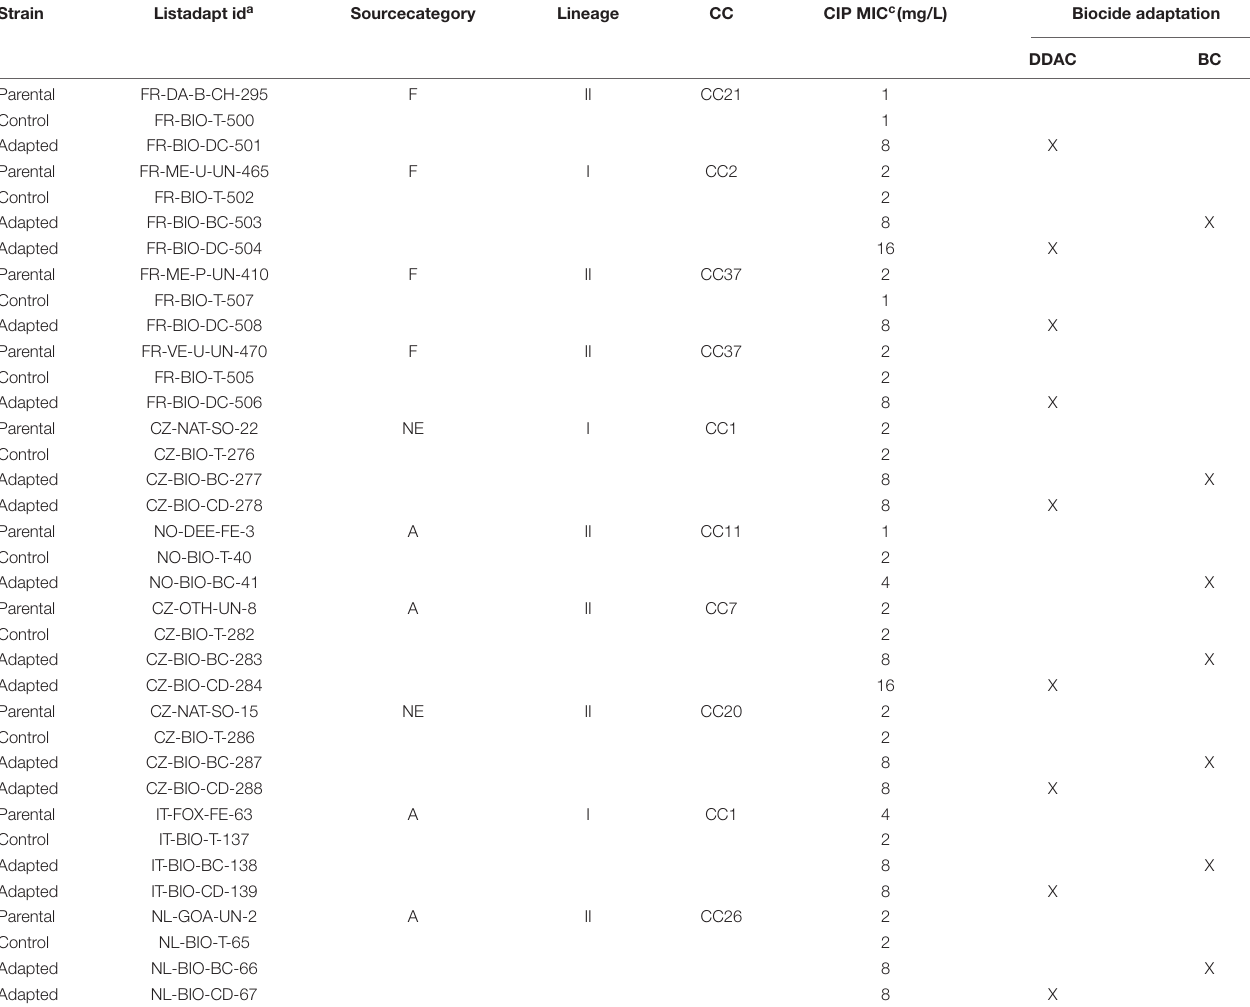
TABLE 1 | Description of the 10 Listeria monocytogenes parental strains and the corresponding strains adapted to the two biocides, benzalkonium chloride (BC), and didecyldimethylammonium chloride (DDAC), or exposed to water (referred to as Control).